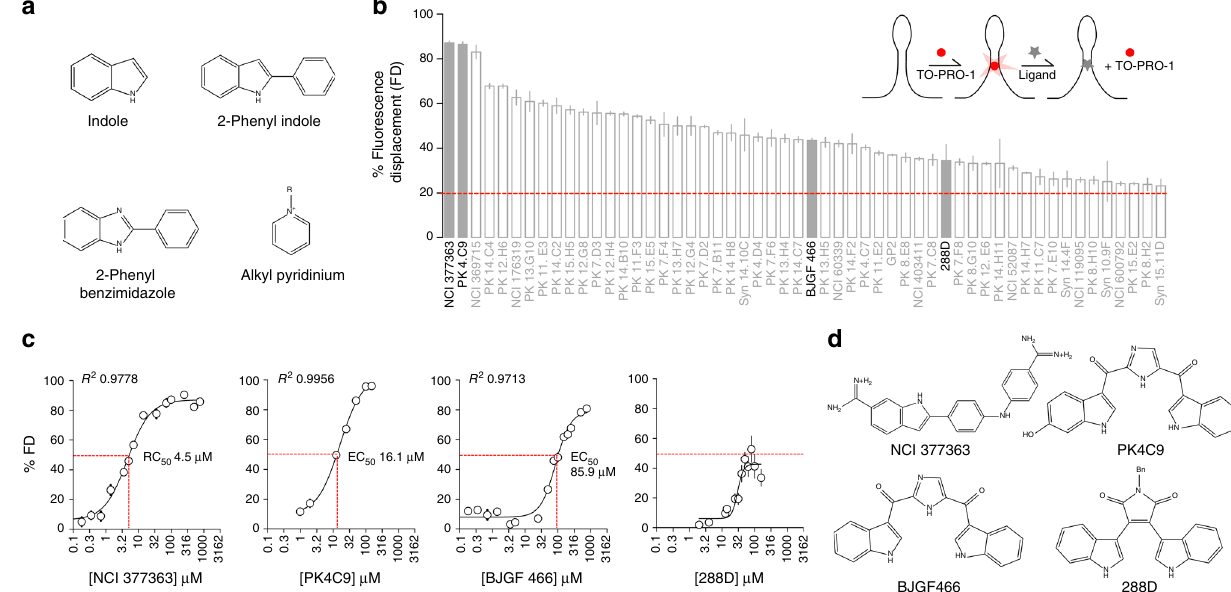
Fig. 2 In vitro screening of a focused library identi fi es TSL2-interacting small molecules. a Selected scaffolds for the building of a 304-compound, focused RNA-binding chemical library. b Ranking of positive hits (100 μ M) from the primary TSL2-interacting screening, with a cut-off value of 20% fl uorescence displacement (FD) relative to DMSO (1%) controls ( n = 4). Hits NCI377363, PK4C9, BJGF466 and 288D are highlighted. c EC50 binding curves and values of hits NCI377363, PK4C9 and BJGF466 to TSL2 ( n = 8; two plates with four replicates each). An EC50 value for 288D could not be calculated due to poor solubility. d Chemical structures of NCI377363, PK4C9, BJGF466 and 288D. Graphs represent mean values ±